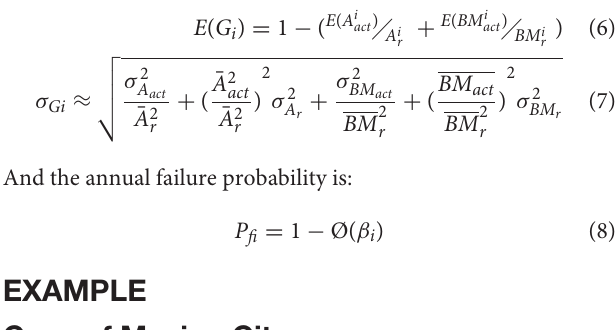
FIGURE 1 | Flowchart of proposed procedure.